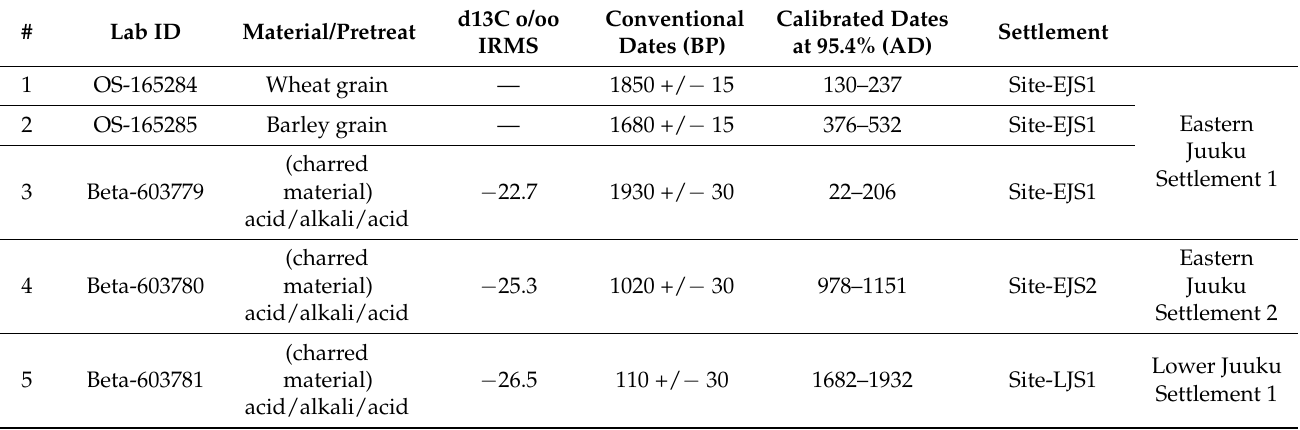
Table 4. Radiocarbon results from carbonized material found at three Settlements recovered from the Juuku